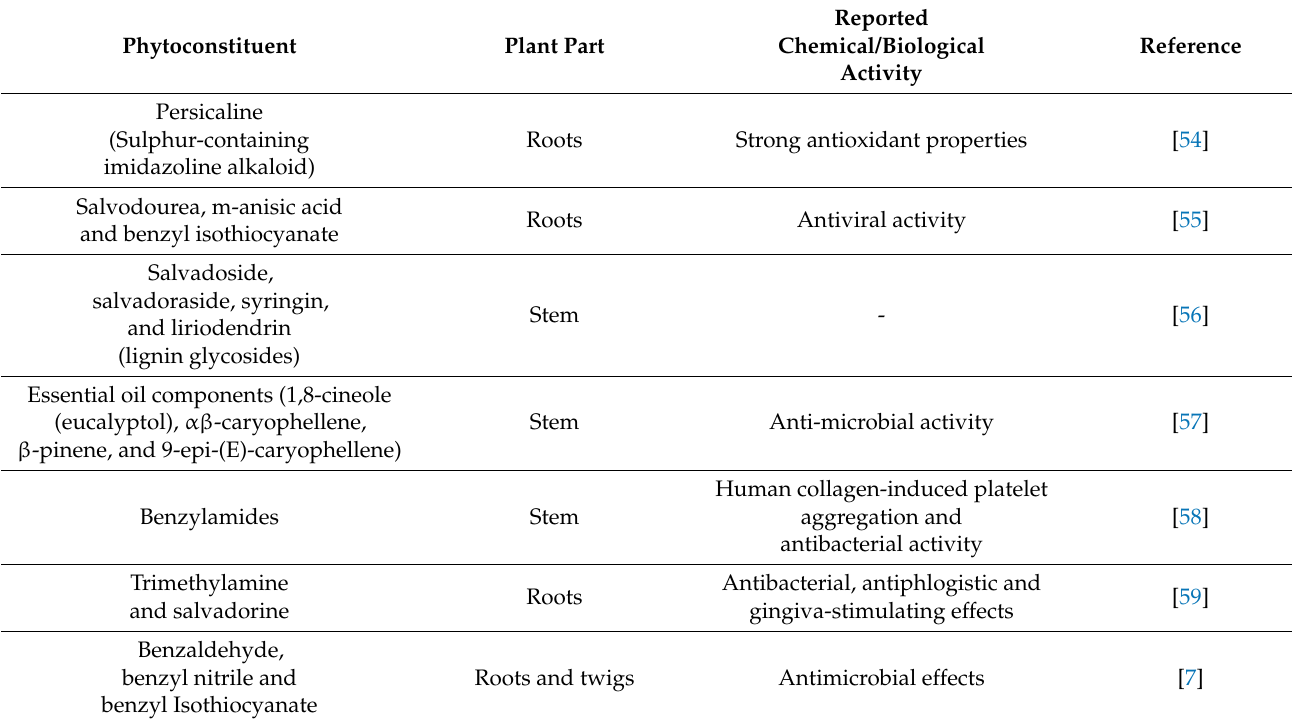
Table 2. Important phytoconstituents of the Salvadora persica extract and their reported chemical/biological activity.